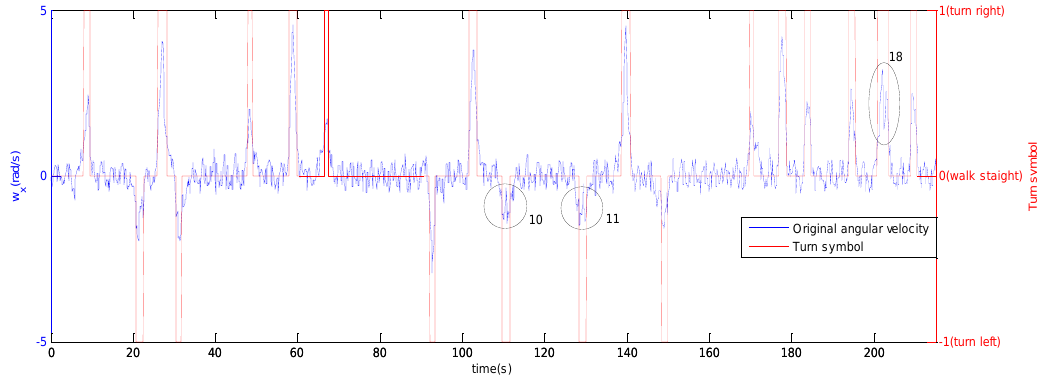
Figure 4. Original angular velocity and the turn symbol based on original data.